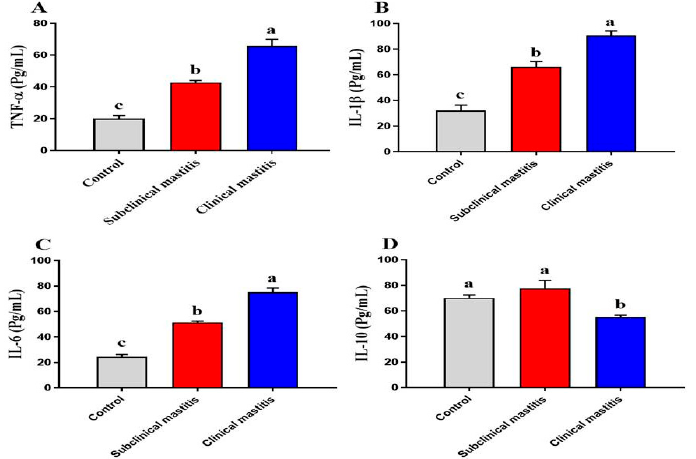
Figure 2. Serum inflammatory Cytokines of dairy cows with subclinical and clinical mastitis. Data were represented as Mean ± SME. This means in with different superscripts are significantly different ( p < 0.05). a significantly different from b and c, a for the high value, b for intermediate value between a and c, while c for the lower value .TNF- α ( A ), IL-1B ( B ), IL-6 ( C ) and IL-10 ( D ).